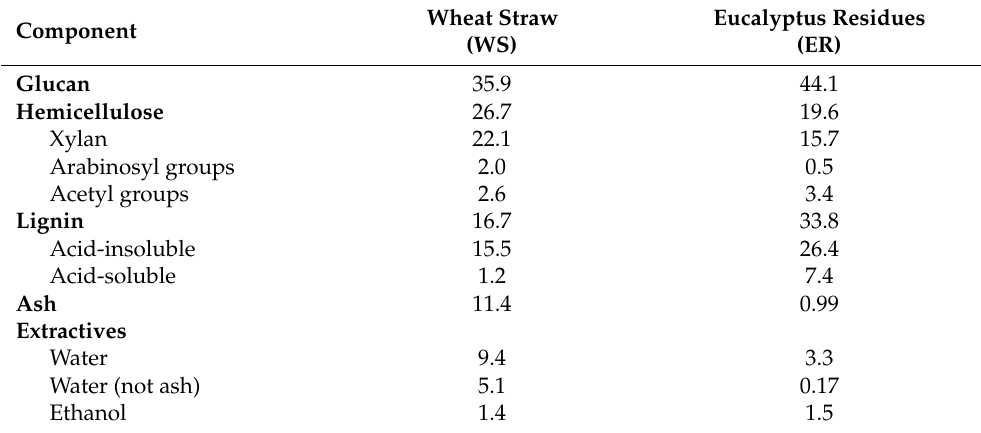
Table 1. Chemical compositions of wheat straw and eucalyptus residues on a dry basis (%). Component